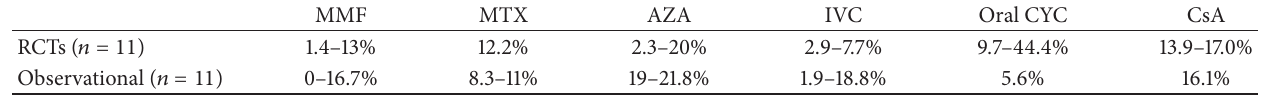
Table 2: Discontinuation rates by intervention and study